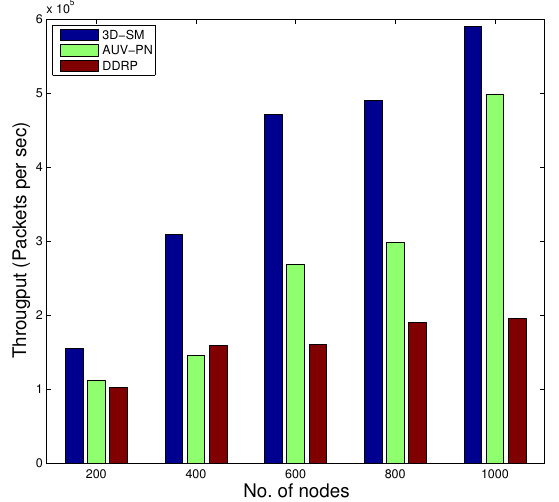
Figure 14. Throughput comparison with different numbers of